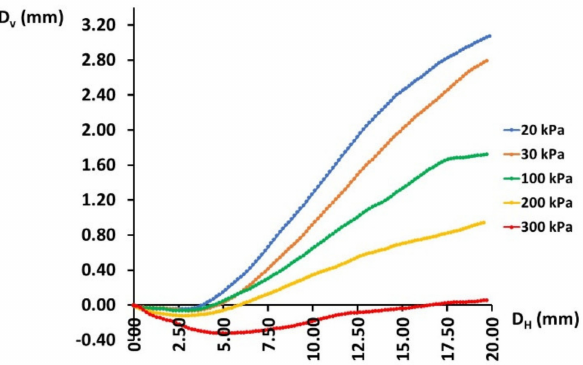
Figure 10. Deformation curves for the wood pellets at the different normal stresses assayed.